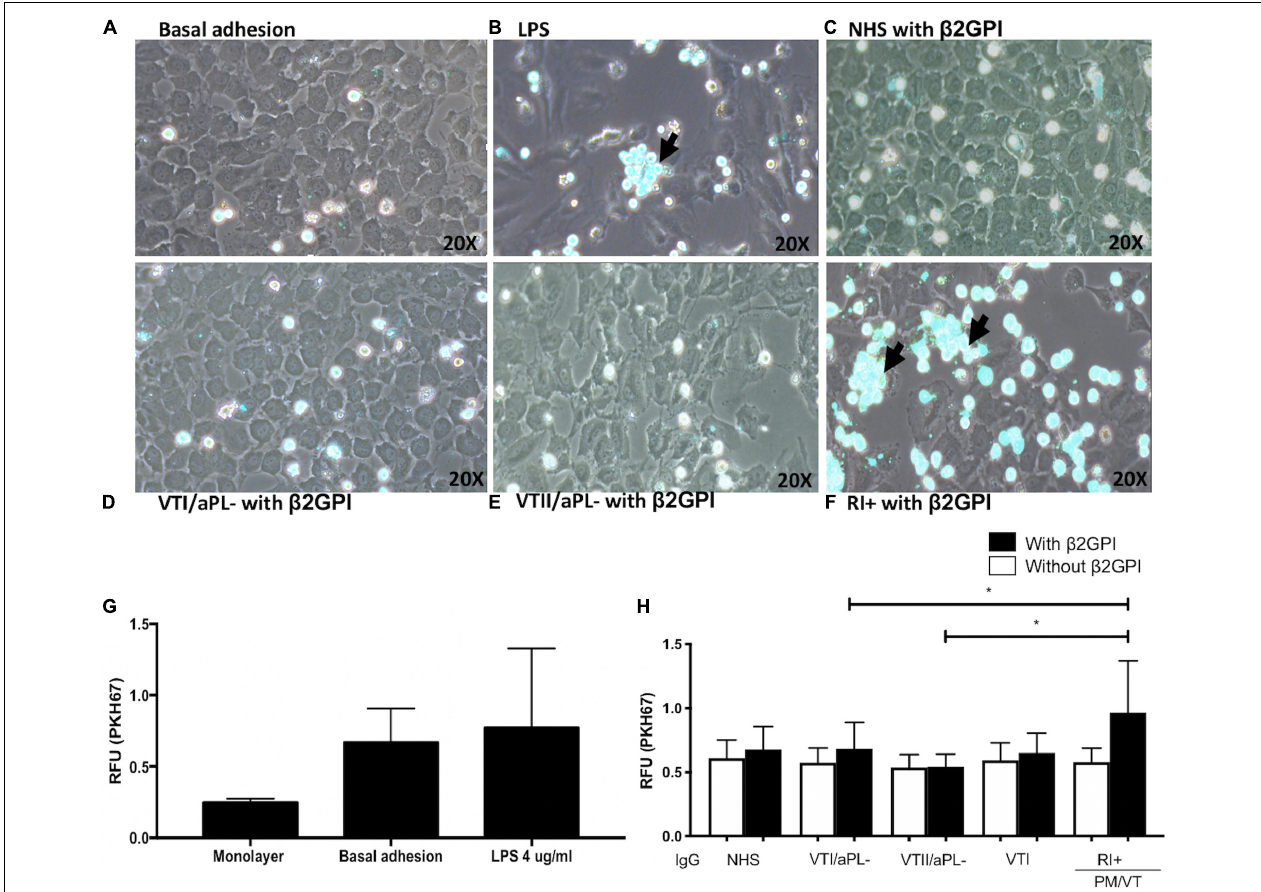
FIGURE 2 | Immunoglobulin-G from patients with refractory and primary obstetric APS (RI+) induces increased monocyte adhesion to the endothelium. (A) Baseline adhesion. (B) LPS. The adhesion of monocytes to the endothelium in cells stimulated with β 2GPI plus: (C) IgG/NHS; (D) IgG/patients negative for aPL with thrombosis without autoimmune disease (VTI/aPL-); (E) IgG/patients negative for aPL with thrombosis and SLE (VTII/aPL-); and (F) IgG/RI + . (A–F) Representative images. (G) The results obtained using the spectrofluorometer are indicated in relative fluorescence units (RFU) emitted by the endothelial monolayer without monocytes and with monocytes attached without stimulus or baseline adhesion and with LPS. (H) IgG from patients with RI + and β 2GPI increased the adhesion of monocytes compared with IgG from patients with VTI/aPL- and VTII/aPL-. A two-way ANOVA and the Holm–Sidak post-test (* p < 0.05) were performed. The results were obtained from three independent experiments. The arrow indicates the aggregates of monocytes. PM/VT, pregnancy morbidity and vascular thrombosis.